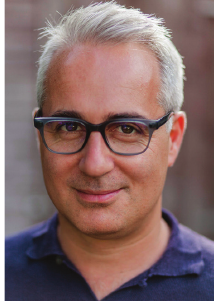
Figure 1 Tobias Stone in 2021 (Source: Tobias